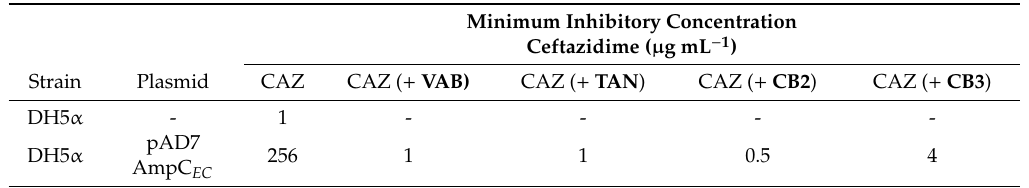
Table 2. Microbiology analyses with vaborbactam (VAB), taniborbactam (TAN), cyclic boronate 2 (CB2) and cyclic boronate 3 (CB3). All inhibitors were tested at a fixed concentration of 4 µ g mL − 1